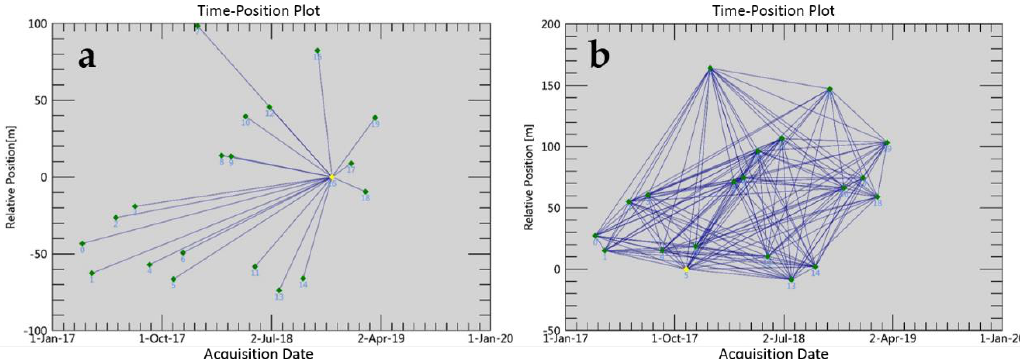
Figure 3. Temporal and spatial baseline distribution of synthetic aperture radar (SAR) interferograms of Sentinel-1A; ( a ) PS analysis; and ( b ) SBAS analysis. The blue lines represent the interferometric pairs, the yellow diamond stands for the super master image and the green diamonds indicate slave images.